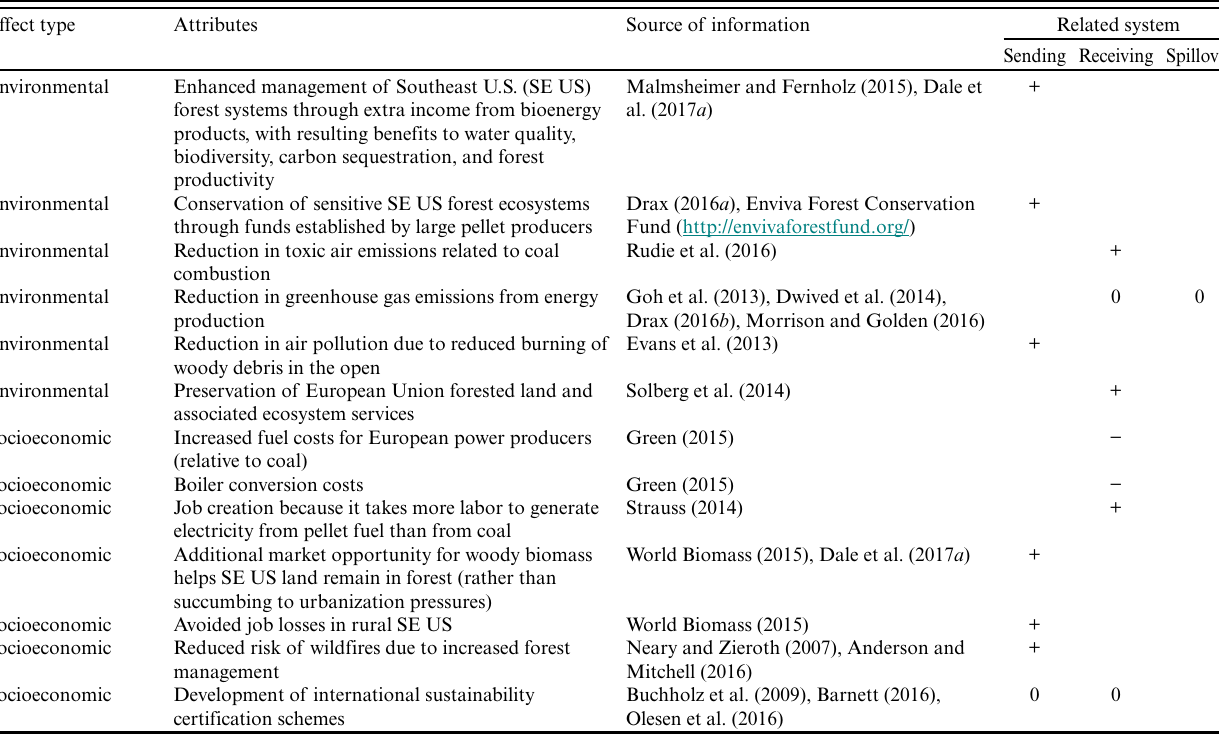
Table 5. Observed effects within the telecoupled transatlantic wood pellet trade system. Positive (+), negative (−), and uncertain (0) effects are indicated for each subsystem (Table